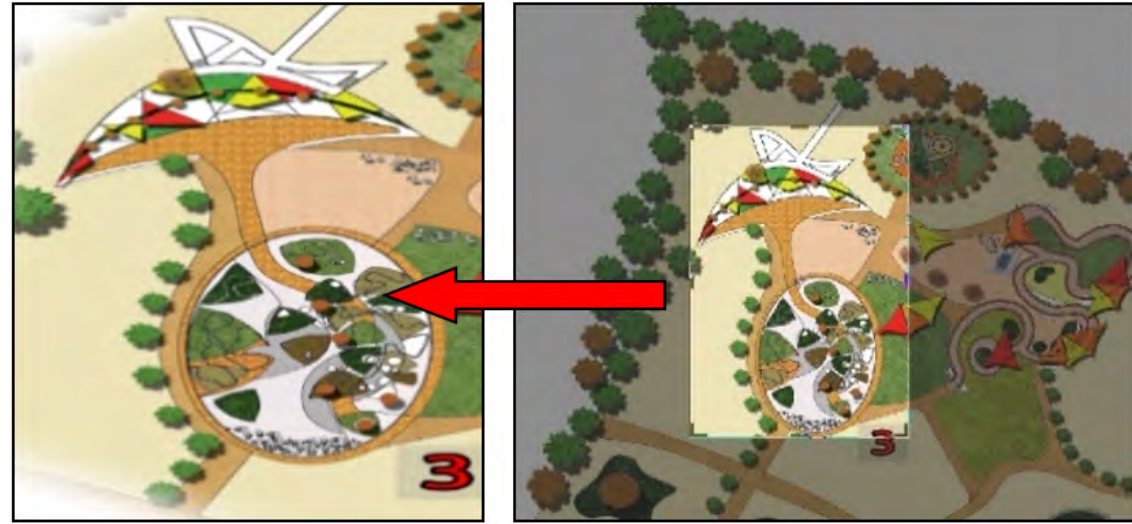
Figure 16. The location of vestibular (balance) and proprioception (muscle and joint) zone